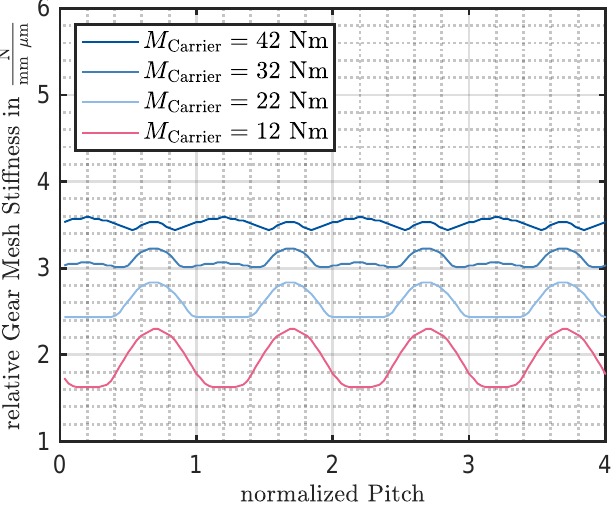
Figure 8. Gear mesh stiffness of the sun and planet